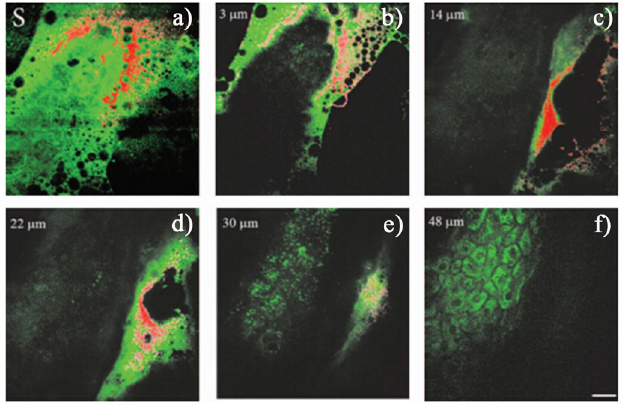
Figure 4. Overlaid multiphoton microscopy images of human skin in vivo (green) and ZnO NPs distribution (red) 4 h after its topical application. En face optical sections of the skin are displayed from ( a – f ) at depths of 0, 3, 14, 22, 30 and 48  m from the skin surface designed S, respectively. Scale bar 20 μ m. Reprinted with permission from reference [78].